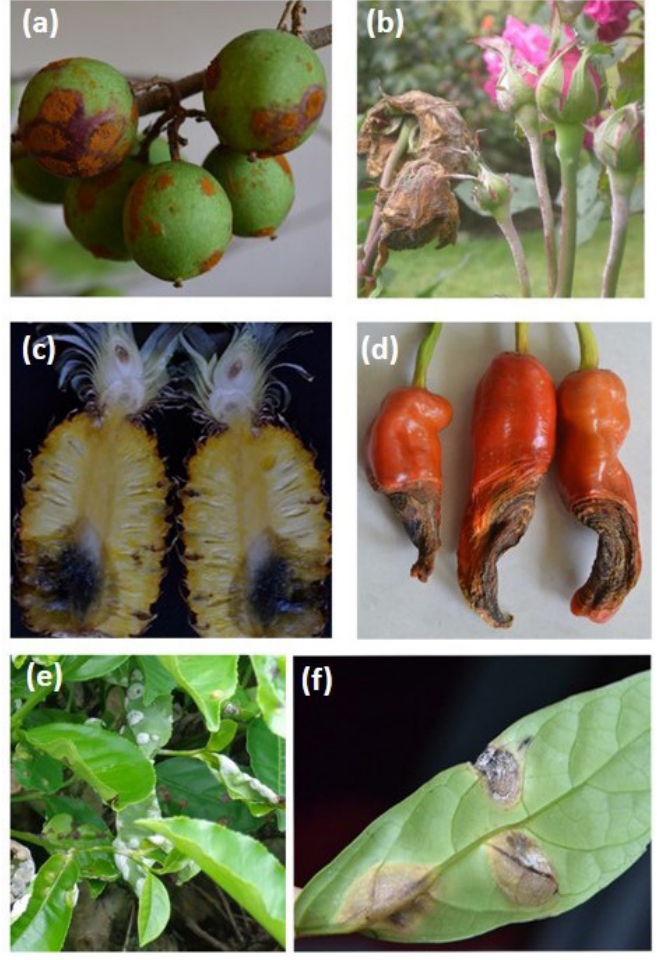
Figure 1: (a) Rust disease in Uguressa (S) ( Flacourtia indica (Burm.f.) Merr . ) fruit caused by Kuehneola flacourtiae (Mundk. & Thirum.) Thirum., (b) Grey mould ( Botrytis cinerea Pers.) infection (Left) of rose ( Rosa chinensis var. Ramblers) and powdery mildew ( Podosphaera pannosa (Wallr.) de Bary) (Right) of bud and stalk, (c) Water blister of pineapple fruit caused by Ceratocystis paradoxa (Dade) C. Moreau., (d) Anthracnose disease by Colletotrichum truncatum (Schwein.) Andrus & W.D. Moore in Capsicum annuum L., (e) Blister blight in tea caused by Exobasidium vexans Massee, and (f) Aecia stage of leaf rust in Clerodendrum wallichii